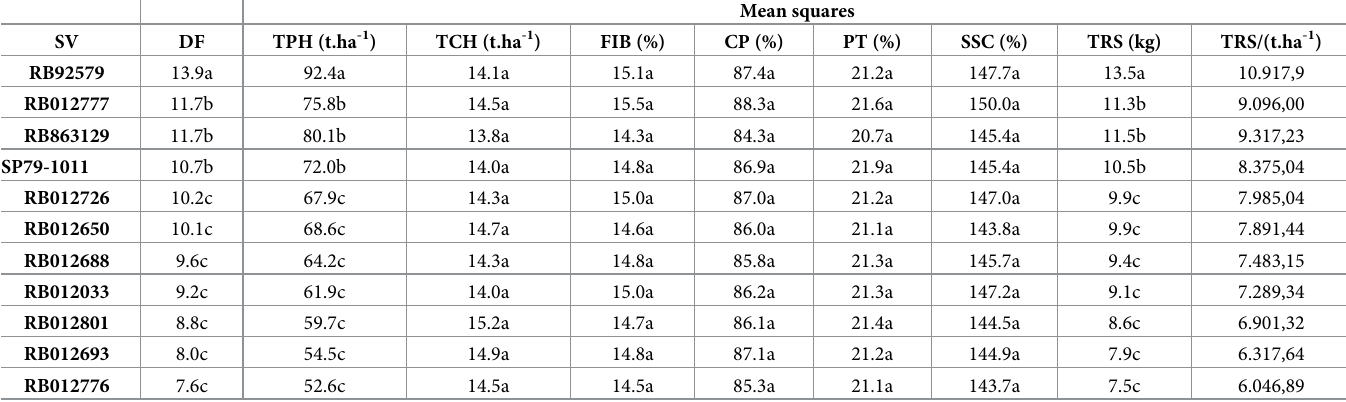
Table 3. Summary of joint analysis of variance of the traits of sugarcane genotypes evaluated over two consecutive years during the final phases of trials conducted in sugarcane microregions in the State of Pernambuco.